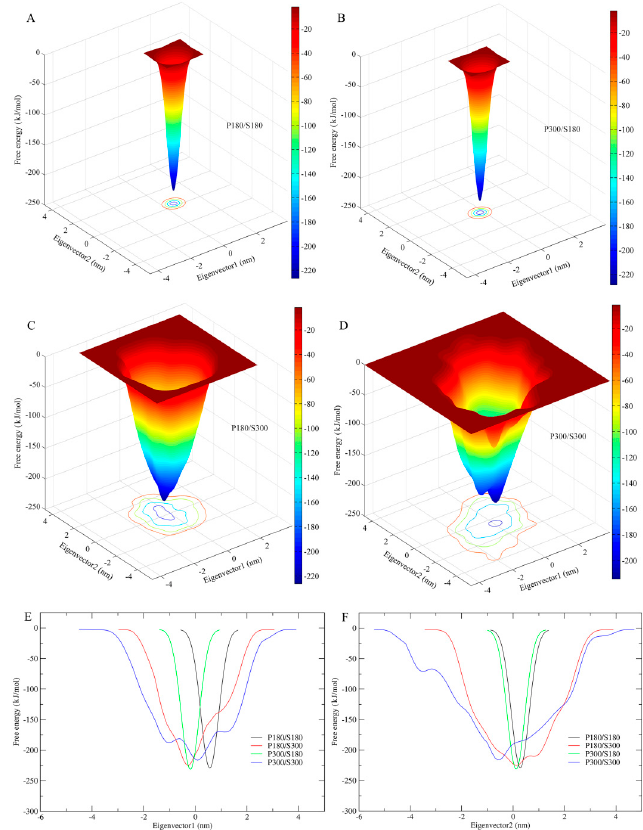
Figure 6. Constructed FELs of the proteinase K-solvent system at the four combined temperatures. ( A – D ) FELs as a function of two-dimensional conformational subspace at the combined temperatures: ( A ) P180/S180; ( B ) P300/S180; ( C ) P180/S300; and ( D ) P300/S300. The color bar represents the free energy value in unit of kJ/mol; ( E , F ) One-dimensional FELs along the projection of the eigenvectors ( E ) 1 and ( F ) 2. Black line: P180/S180; red line: P180/S300; green line: P300/S180; blue line: P300/S300.